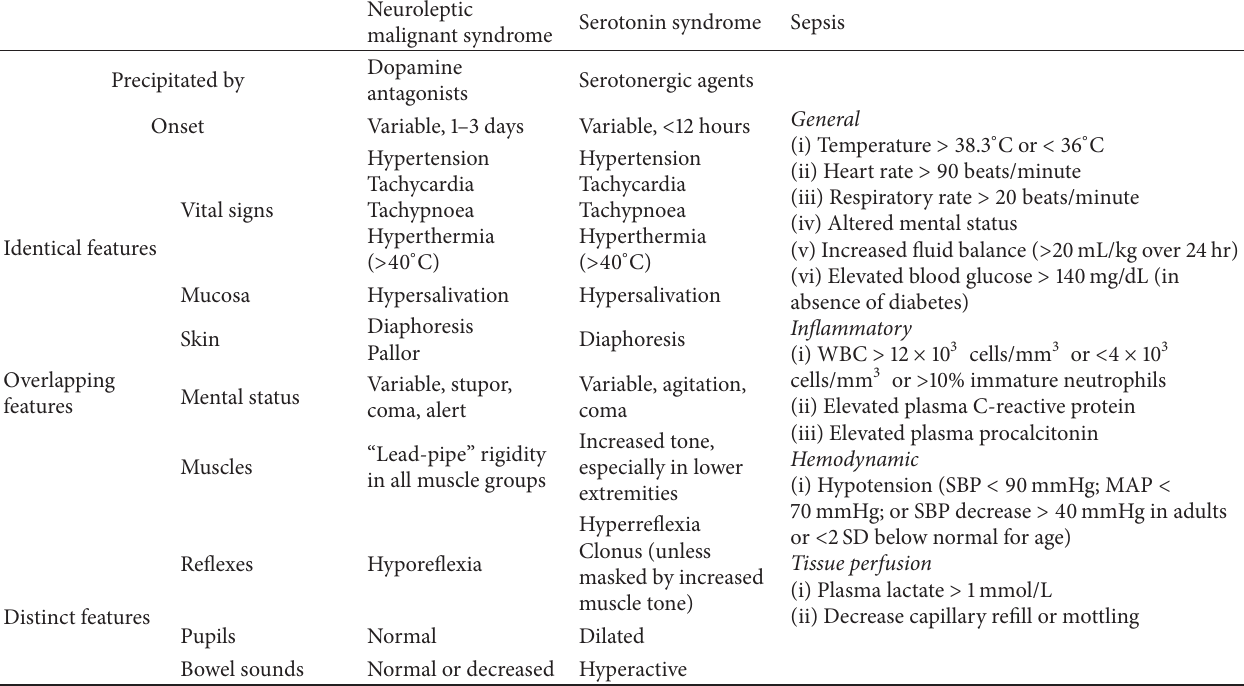
Table 1: Characteristics of neuroleptic malignant syndrome, serotonin syndrome, and